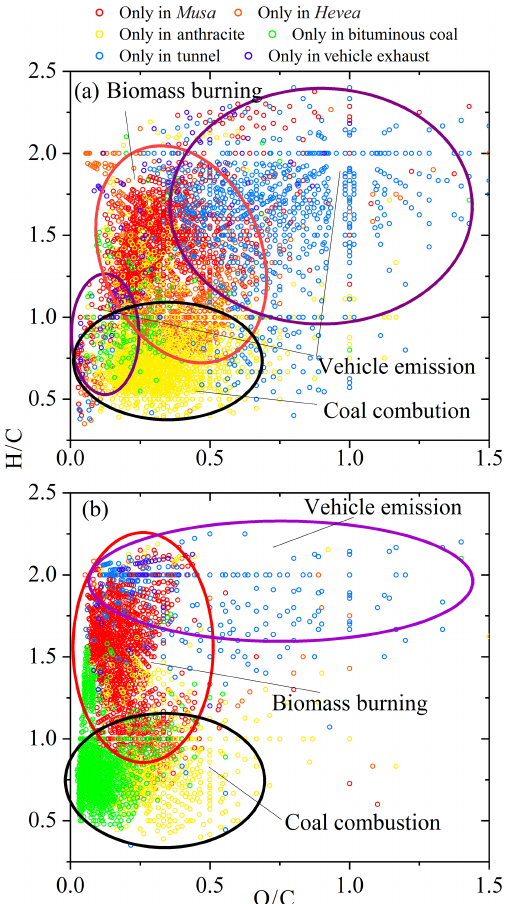
Figure 5. A van Krevelen diagram of WSOC (a) and MSOC (b) from the six aerosol samples. Different color indicates unique formulas detected in each